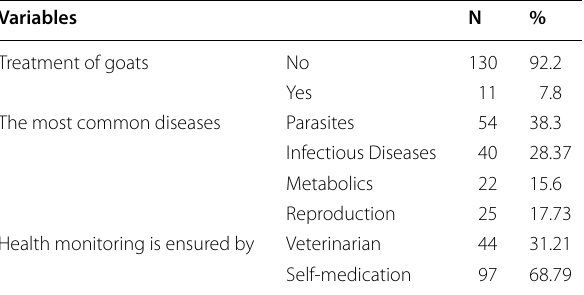
Table 5 Health management in the different goat